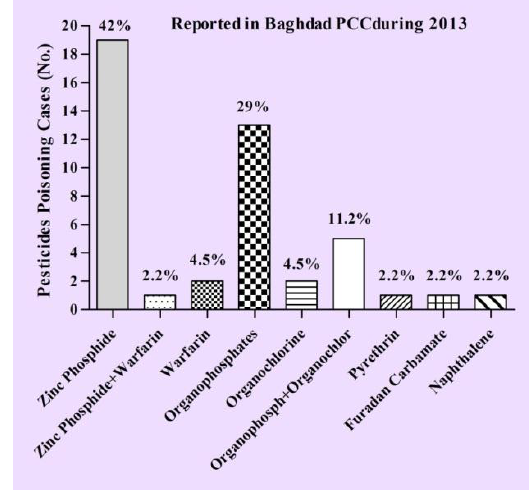
Figure (6): Distribution of poisoning cases reported in the Forensic Medicine Institute during 2013 according to the poison type. In Baghdad PCC, the highest percent of reported poisoning cases were attributed to metals (82.2%), while unspecified types of drugs predispose to 7.1% cases, followed by pesticides and amanita phalloids, which represent 4.2% and 0.5% of the reported cases at that center, respectively (Figure 7).